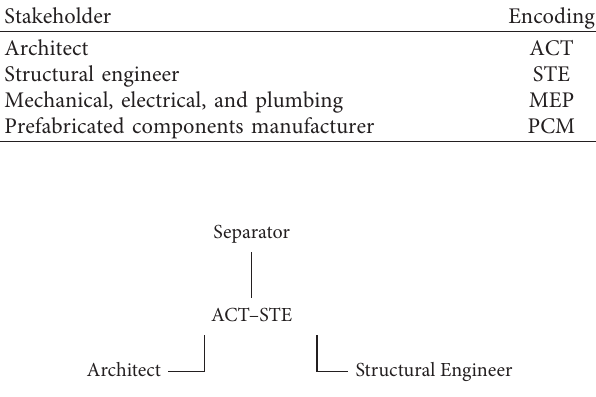
Figure 13: Encoding example of exchange items (model creator: Architect, model receiver: Structural